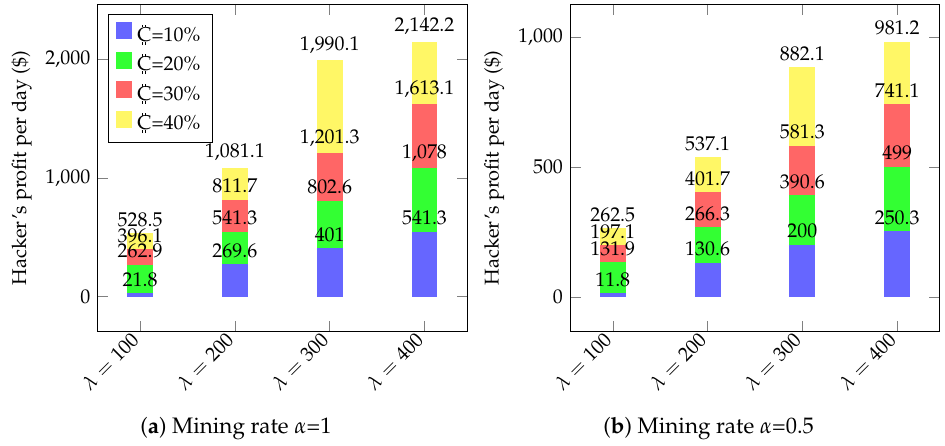
Figure 7. Earnings per day with variable cryptojacked infected vehicles with varying α values.